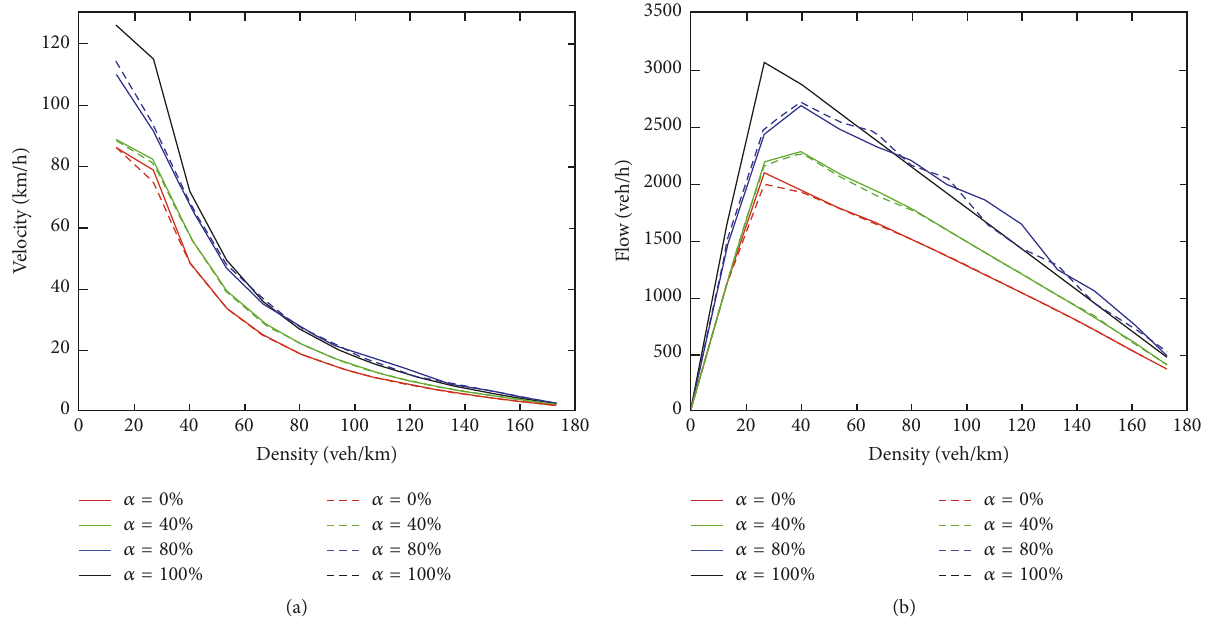
Figure 2: Fundamental diagrams of mixed traffic flow.